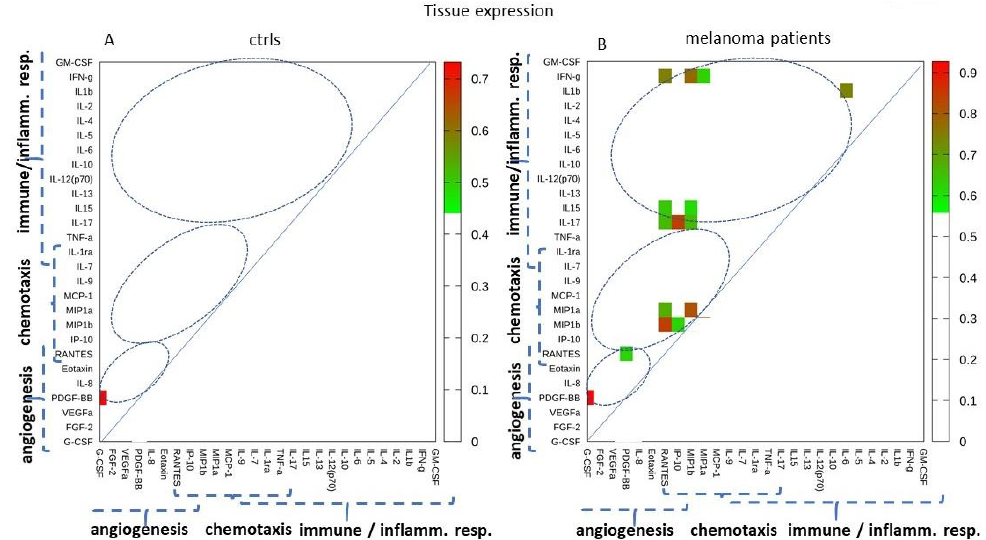
Figure 5. Correlations of the tissue expression values. The heatmap shows the correlation among pairs of expression values with a p < 0.05 and Spearman’s rank coefficient >0.60.